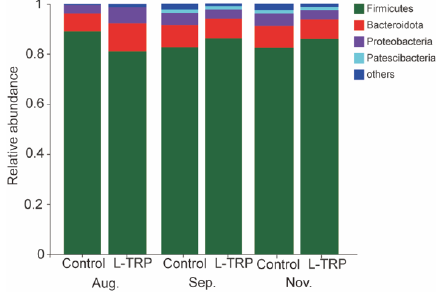
Figure 6. Structure and composition of the intestinal microbial composition of E. sinensis (phylum level) in August, September and November. Each color bar represented a phylum, and the height of